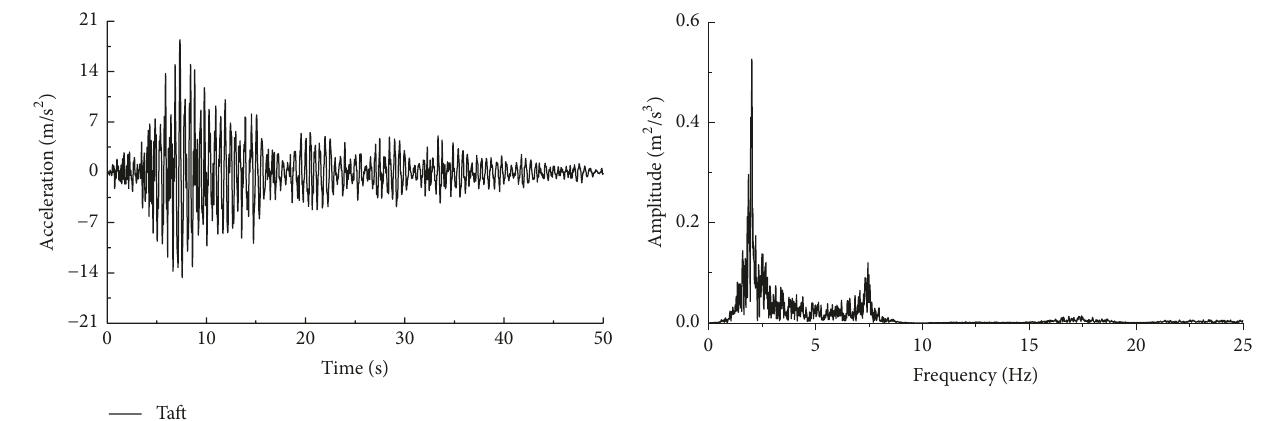
Figure 20: Horizontal acceleration time history and Fourier spectrum curves at node 103 under Taft wave (HV case).